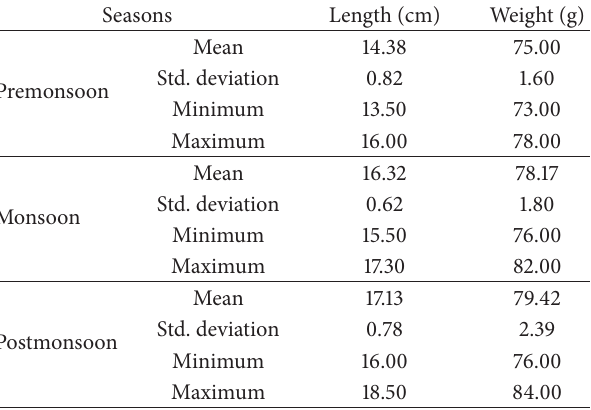
Table 1: Mean ± SD, minimum and maximum of length (cm) and weight (g) of Terapon puta during different seasons of the year